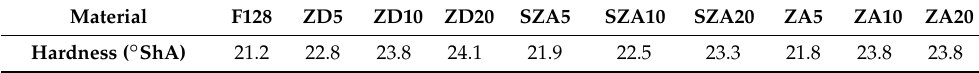
Figure 4. Hardness of the tested materials. Table 4. Hardness values of the tested materials. Table 4. Hardness values of the tested materials.